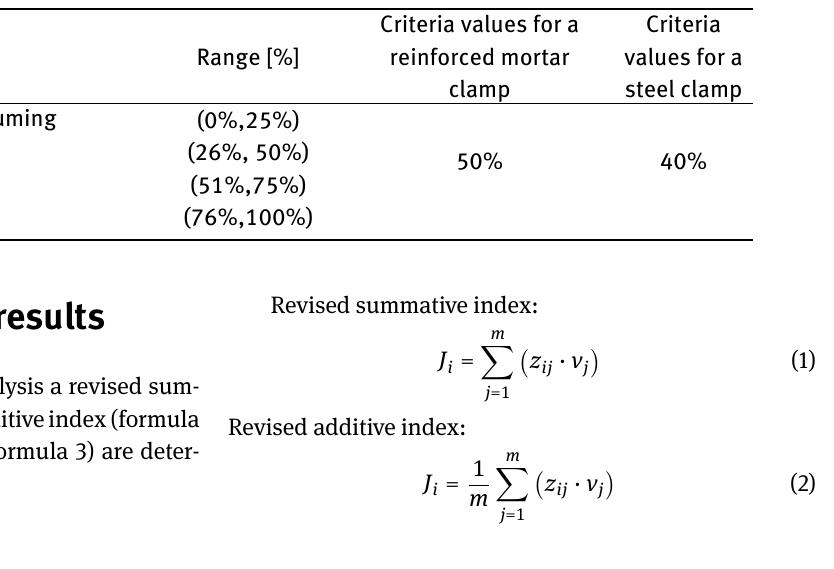
Table 5: Values for the criterion: impact on visual aesthetics (own